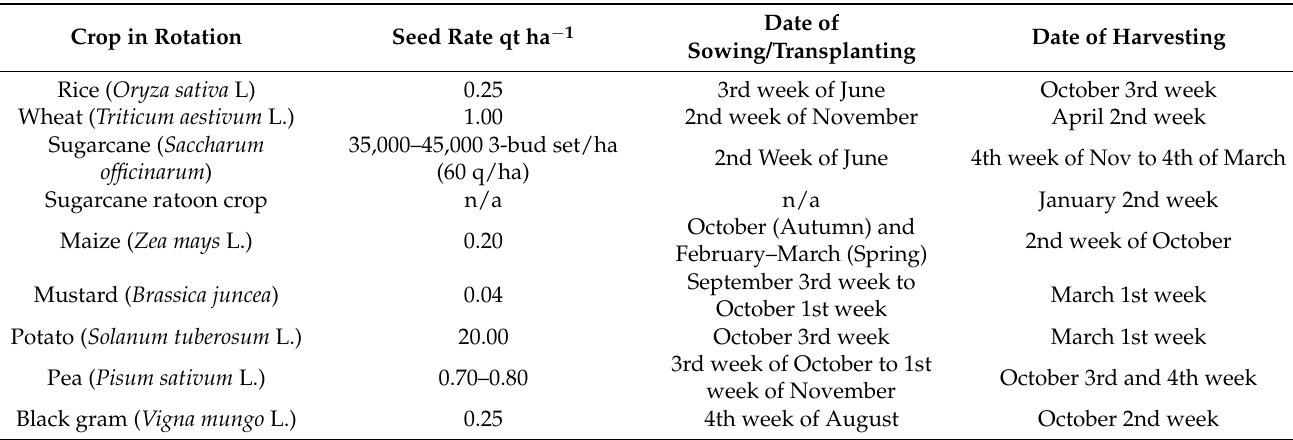
Table 3. Agronomic practices of crops in experimental rotations. Crop in